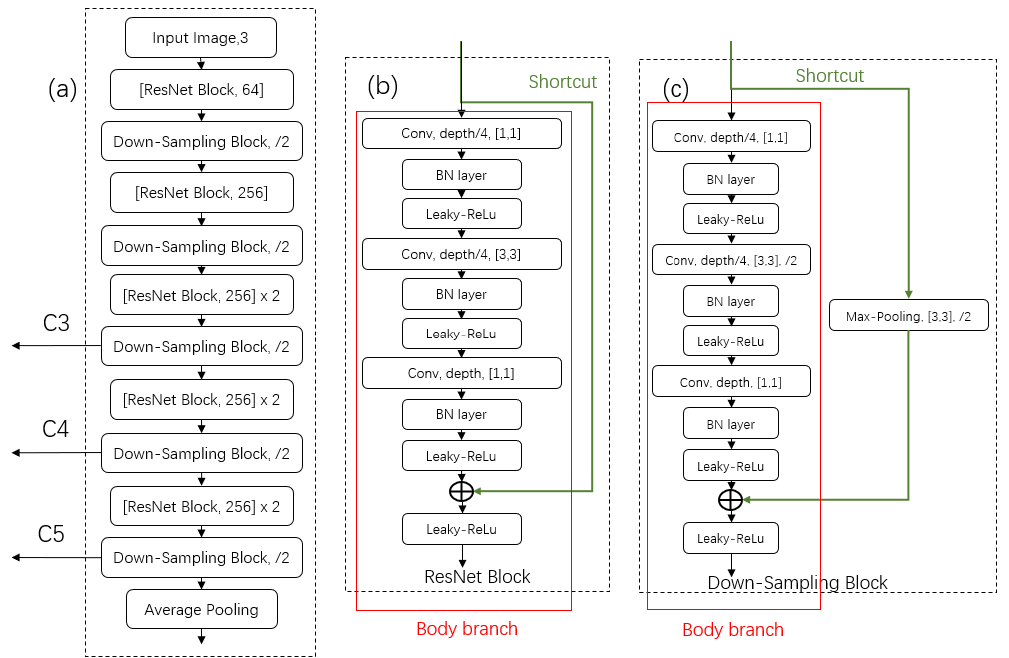
Figure 7. The architecture of the lw-net: ( a ) the lw-net architecture; and ( b , c ) the bottleneck residual network block and down-sampling block architectures,